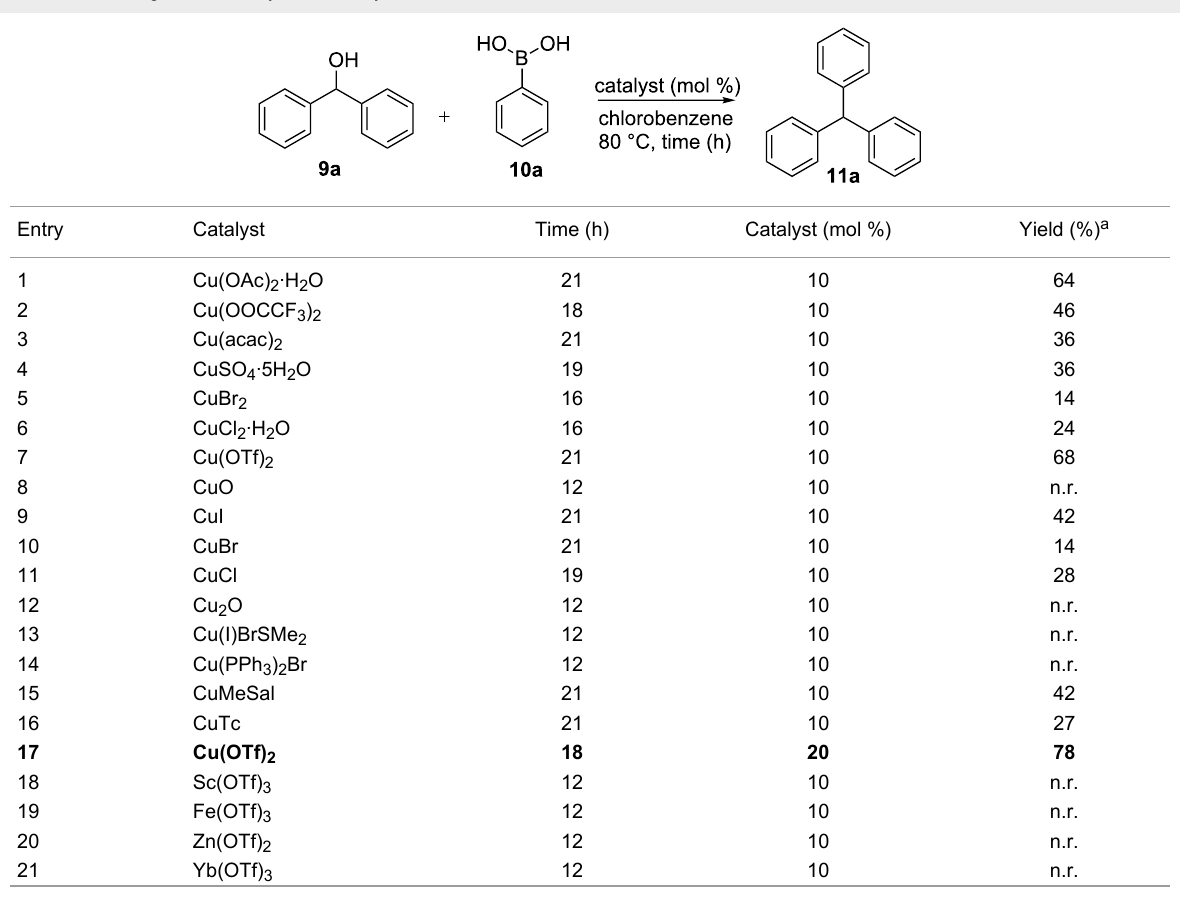
Table 1: Screening of metal catalysts for the arylation